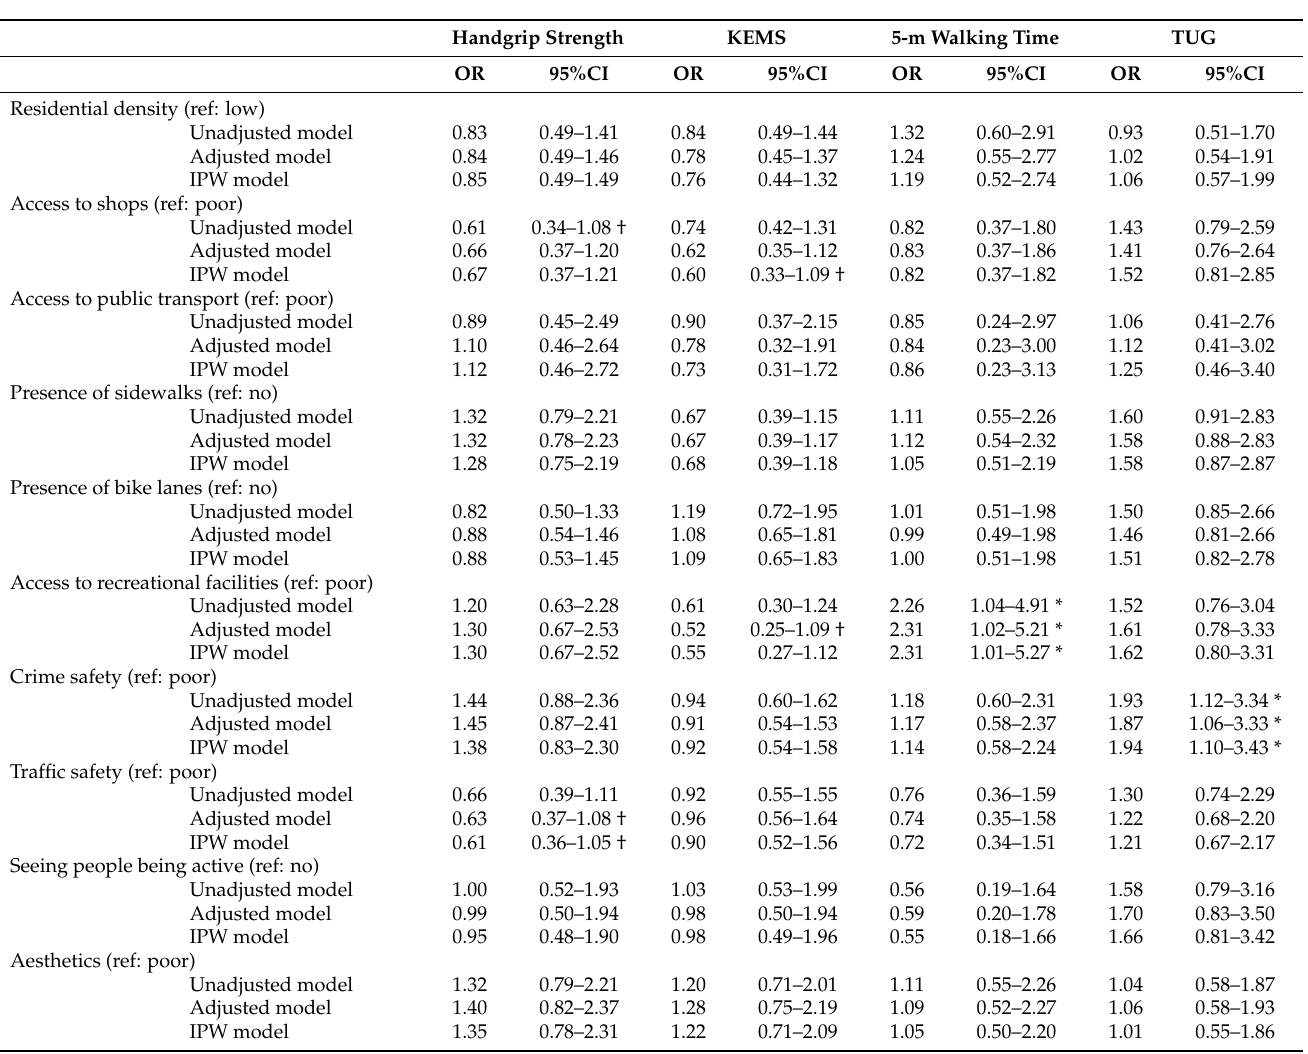
Table 3. Effects of perceived neighborhood environment on physical function by multiple logistic regression